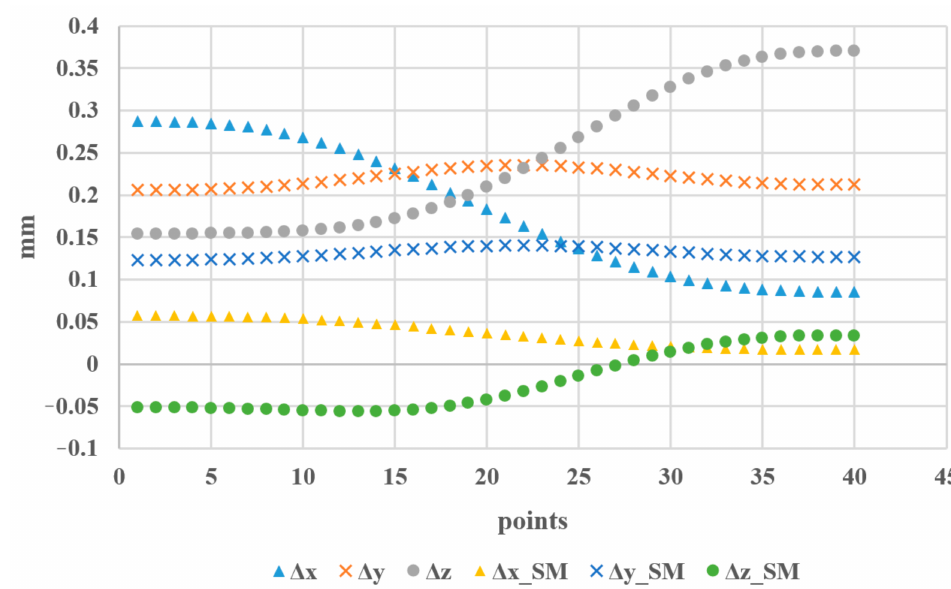
Figure 9. Spatial coordinate errors before the error